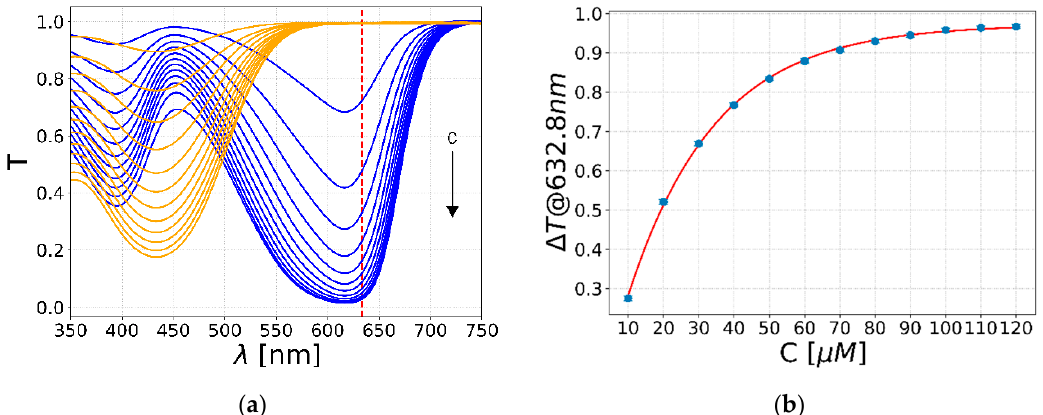
Figure 7. Concentration spectral analysis of Bromothymol Blue. ( a ) The graph reports the transmission spectra in the visible range; the blue lines are the spectra of the 12 solutions with 6 pH, whereas the orange ones refer to solutions with 7.6 pH. The arrow indicates the increasing concentration of the pH indicator in the two solutions. ( b ) The transmittance difference Δ T between the two solutions at 632.8 nm is plotted in the function of Bromothymol Blue concentration.